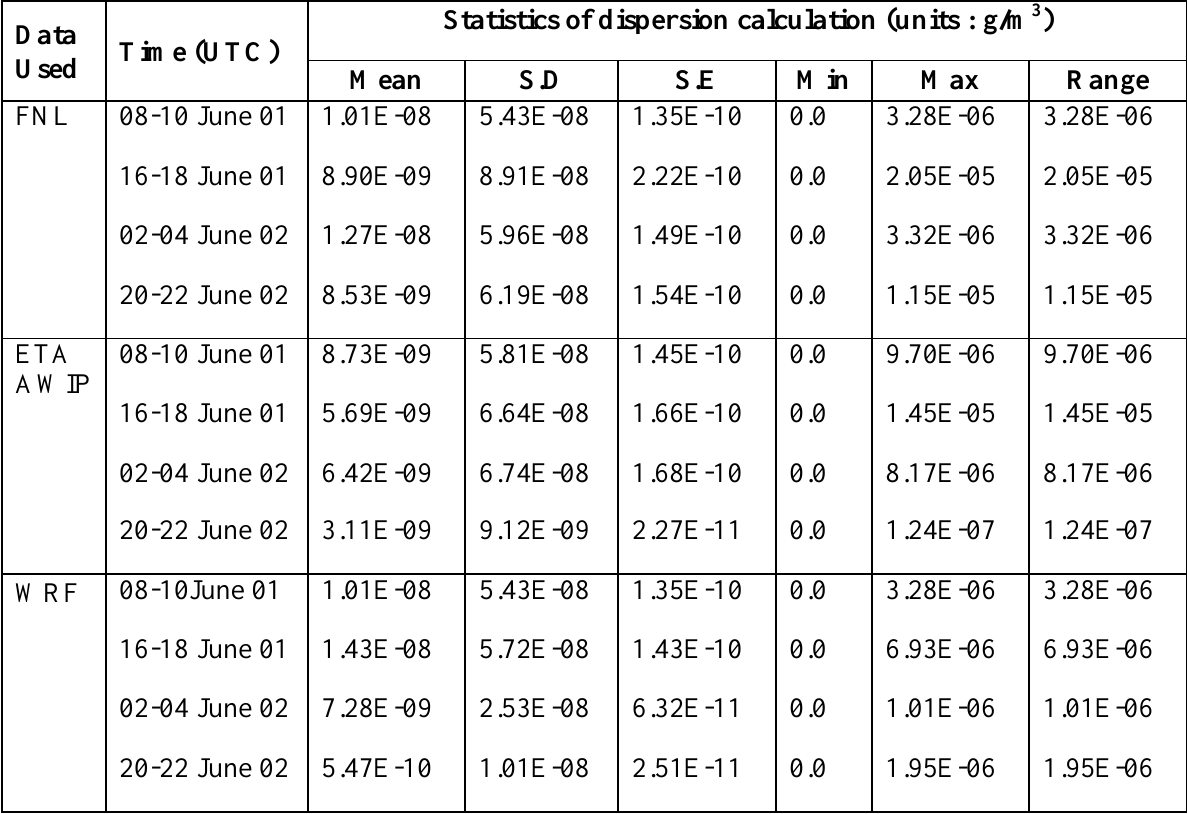
Table 4. Statistics of the dispersion calculation with different input meteorological data. (S.D- standard deviation, S.E- Standard error), units are in g/m 3 .